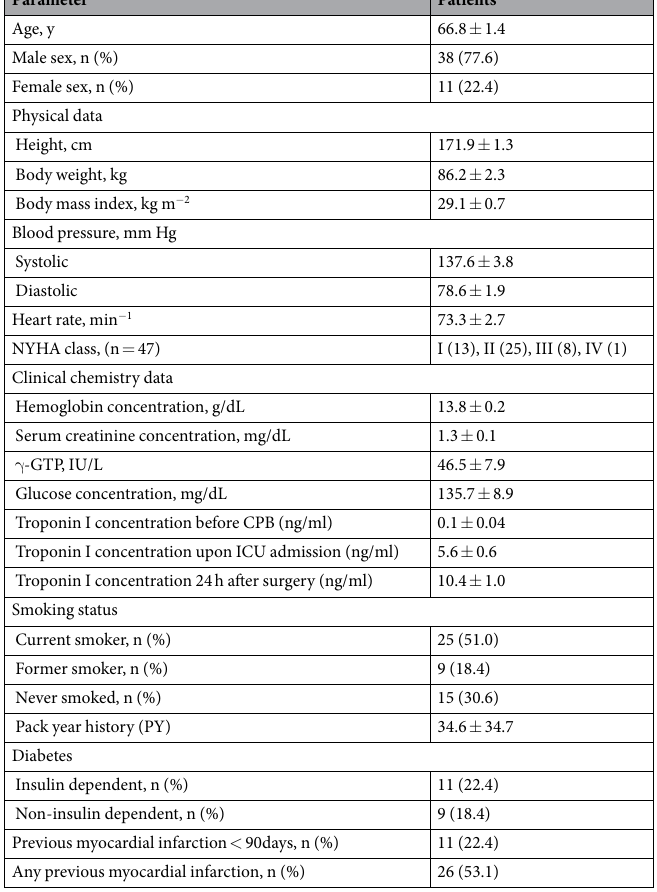
Table 1. Characteristics of patients. Data are presented as means ± SEM. NYHA, New York Heart Association grade for heart failure. ICU intensive care unit.